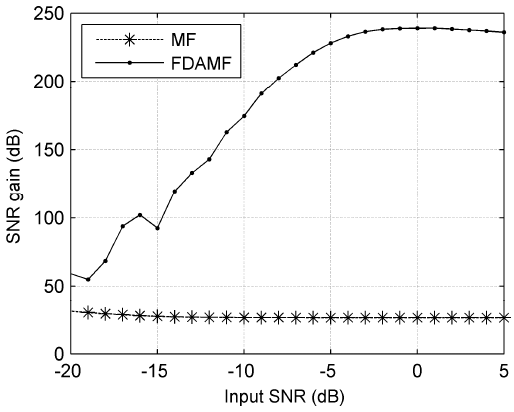
Figure 9. The SNR gain curves of the MF and the FDAMF at different SNRs in additive white Gaussian noise (AWGN).